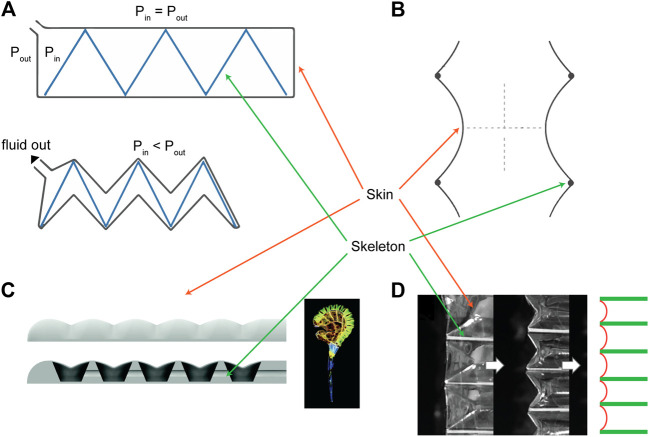
Overview of existing skin-skeleton vacuum actuator designs, highlighting the skin and skeleton components. These include (A) FOAMs (Li et al., 2017), (B) Bellows actuators (Felt et al., 2018), (C) bending soft actuators (Tawk et al., 2018), and (D) Origami bellows actuator (Lee and Rodrigue, 2019). All figure reproductions approved by publishers.